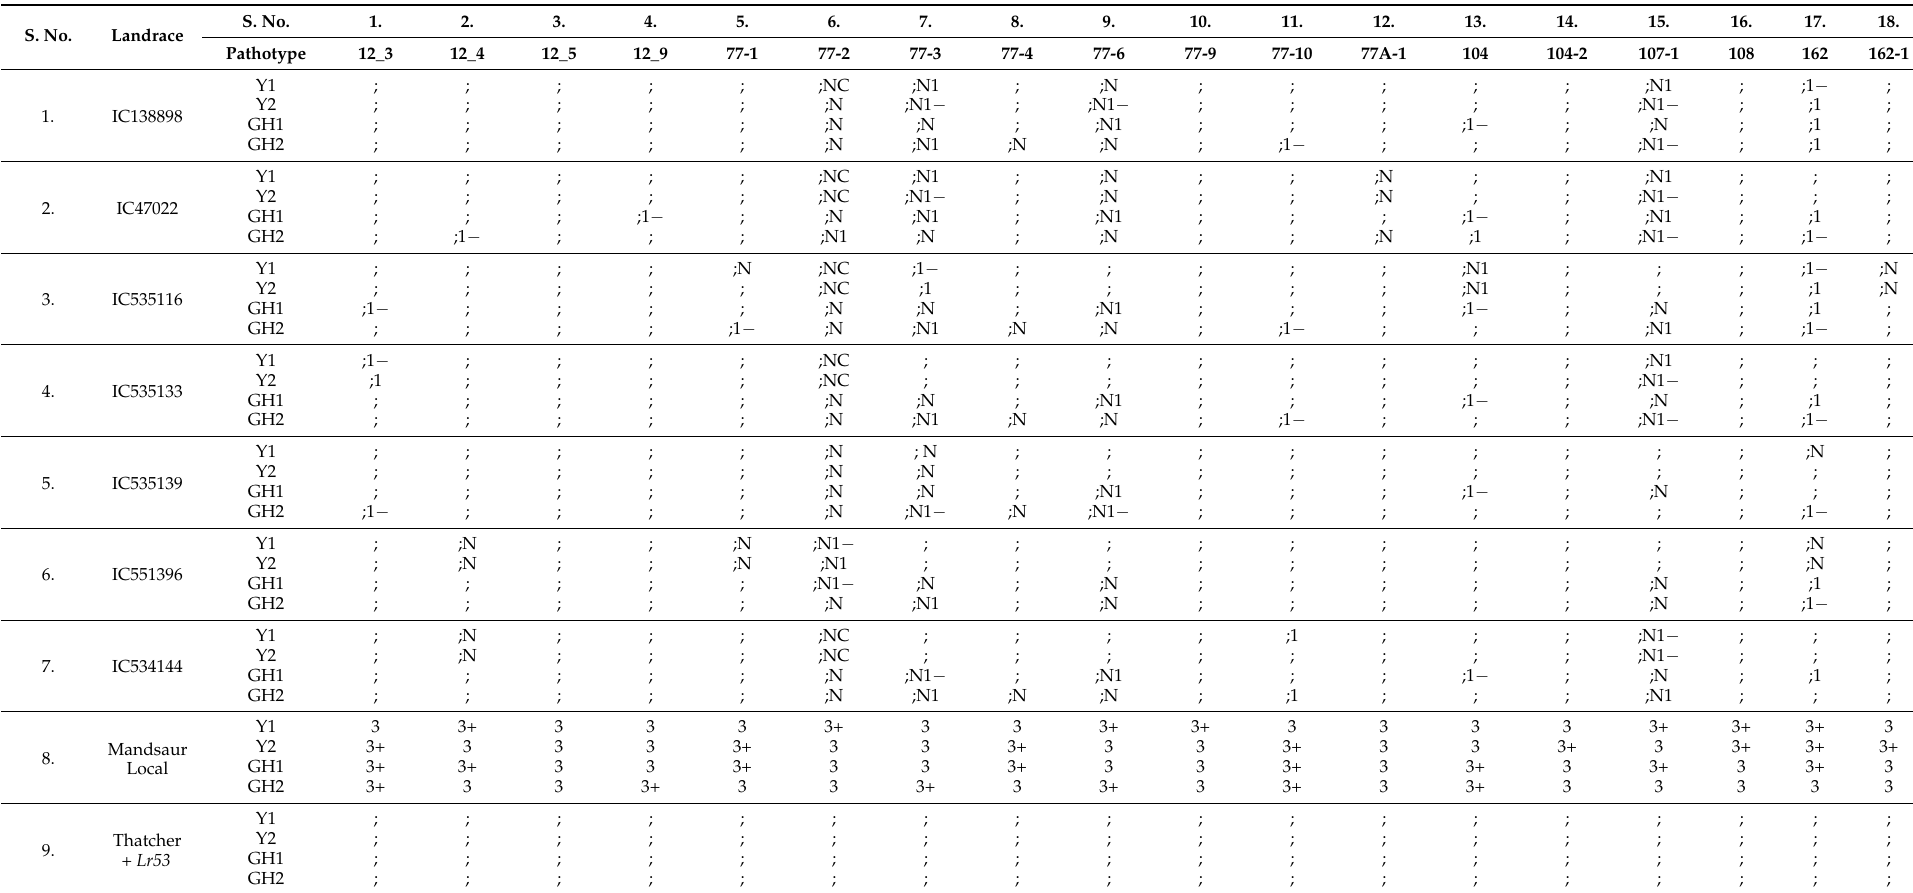
Table 2. Screening of dicoccum germplasm lines along with positive control, Thatcher + Lr53 stock, and negative control, Mandsaur Local, against 18 pathotypes of Puccinia triticina Eriks in four environments, at seedling